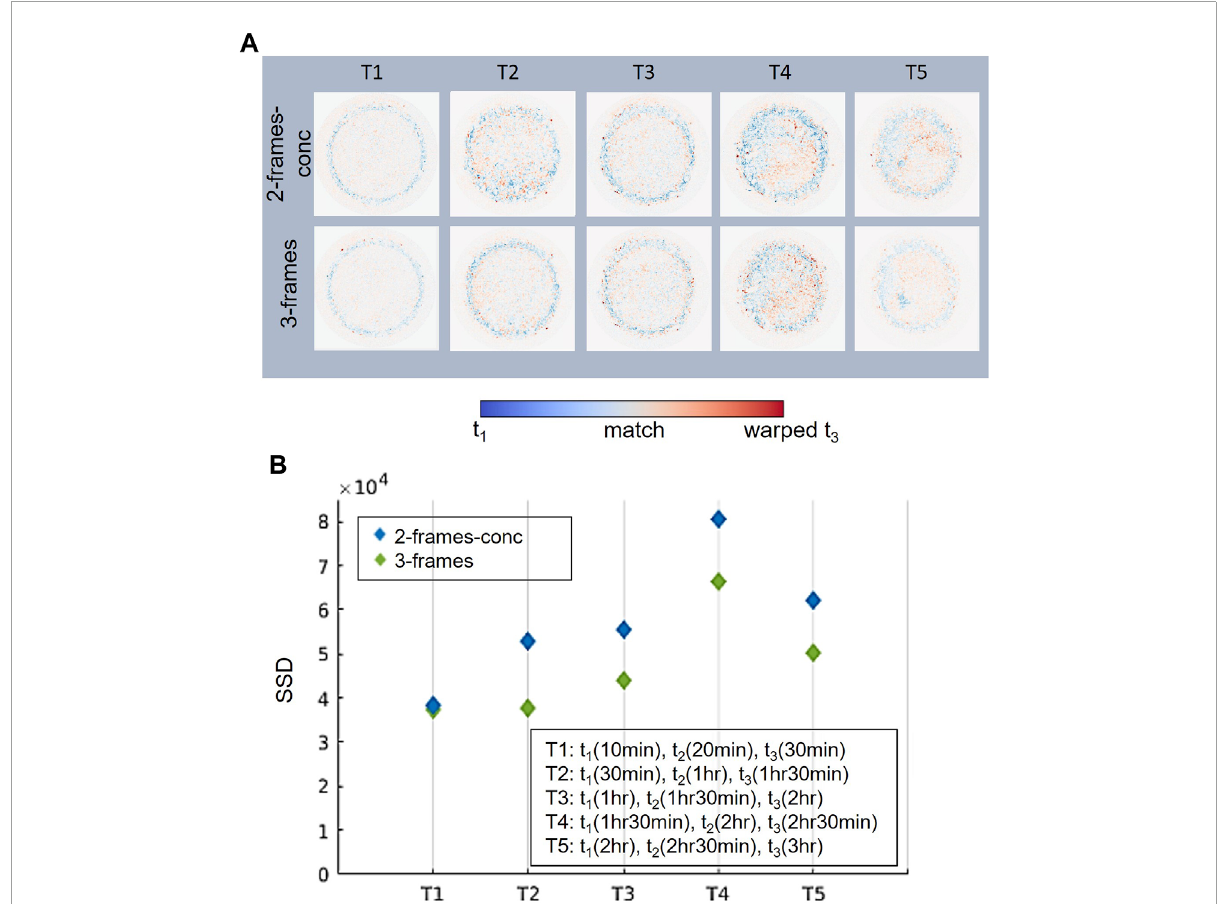
FIGURE 4 (A) Central slices of the consistency map defined as the difference between the reference (i.e., first frame of the temporal sequence) and deformed volumes (i.e., deformed last frame of the temporal sequence): blue regions correspond to material of t 1 does not match material in the warped t 3 ; red regions correspond to material of the warped t 3 does not match material in t 1 ; white regions correspond to material of warped t 3 that fully overlaps material in t 1 . The first row is related to the 2-frames-conc method and the second row is related to the 3-frames method. Five triplets have been analyzed, from T1 to T5. (B) Registration accuracy evaluated by SSD metric for the five